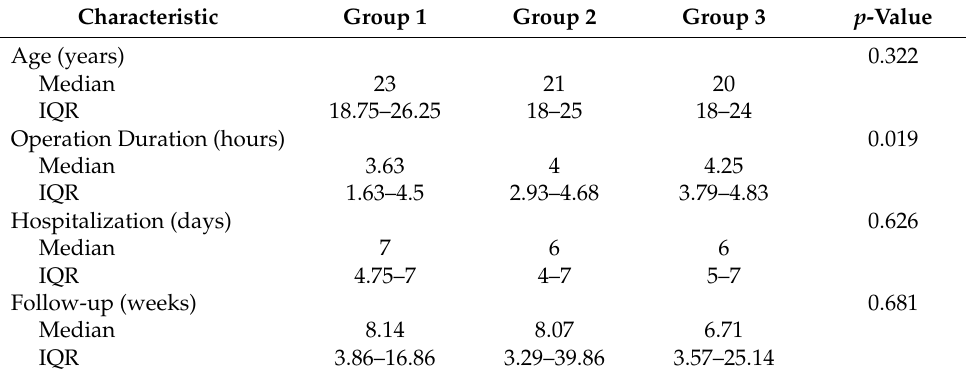
Table 1. Table 1. Characteristics of the study groups.